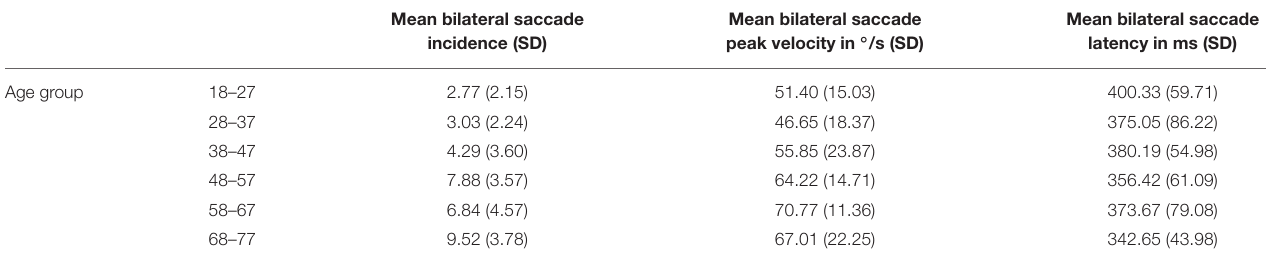
TABLE 2 | Mean bilateral saccade metrics for age.